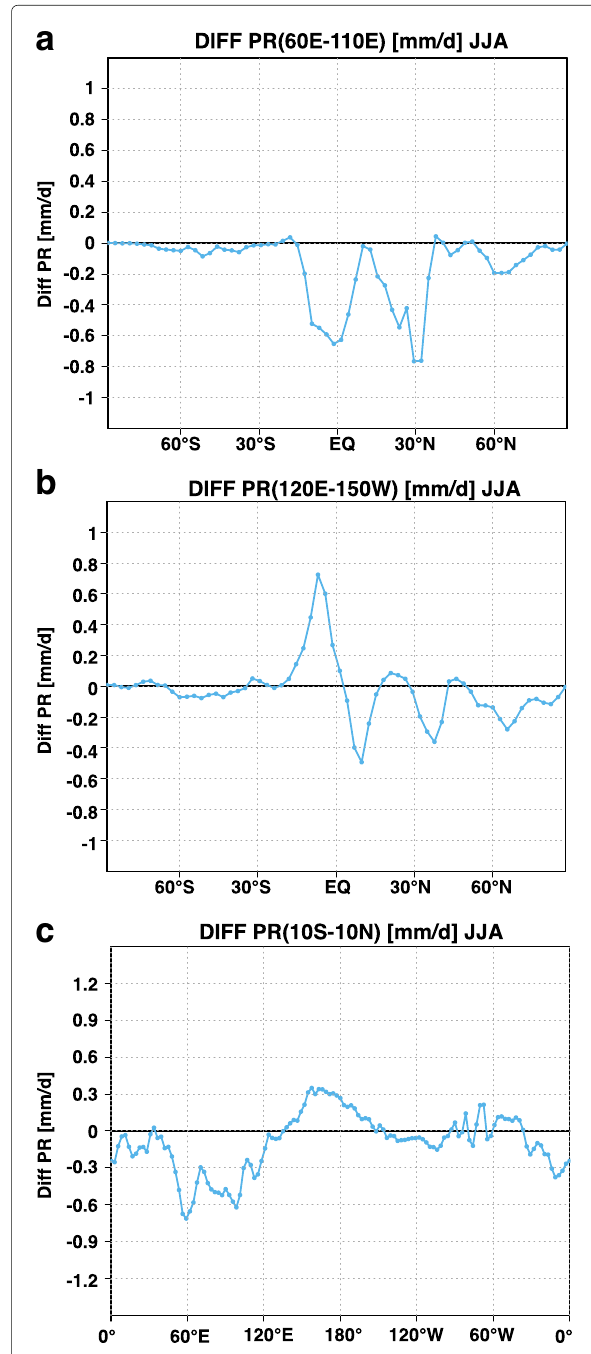
Fig. 5 Meridional distribution of zonally averaged precipitation a over the longitudinal band of the Asian monsoon region (60° E–110° E) and b over the longitudinal band of the Pacific Ocean (120° E–150° W) during JJA. c Zonal distribution of meridional mean precipitation over the latitudinal band of the equator region (10° S–10° N). The blue line indicates the differences in zonal or meridional mean precipitation between 30-year mean HIST from 1976 to 2005 and piAERO from 1976 to 2005. Note that the statistically insignificant values are also plotted in this